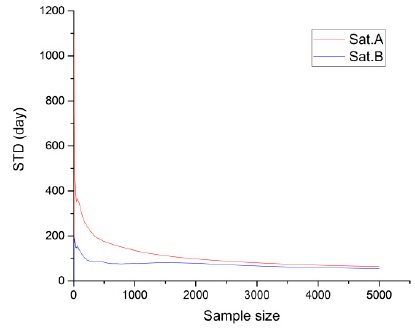
Figure 11. Convergence range of the standard deviation (STD).